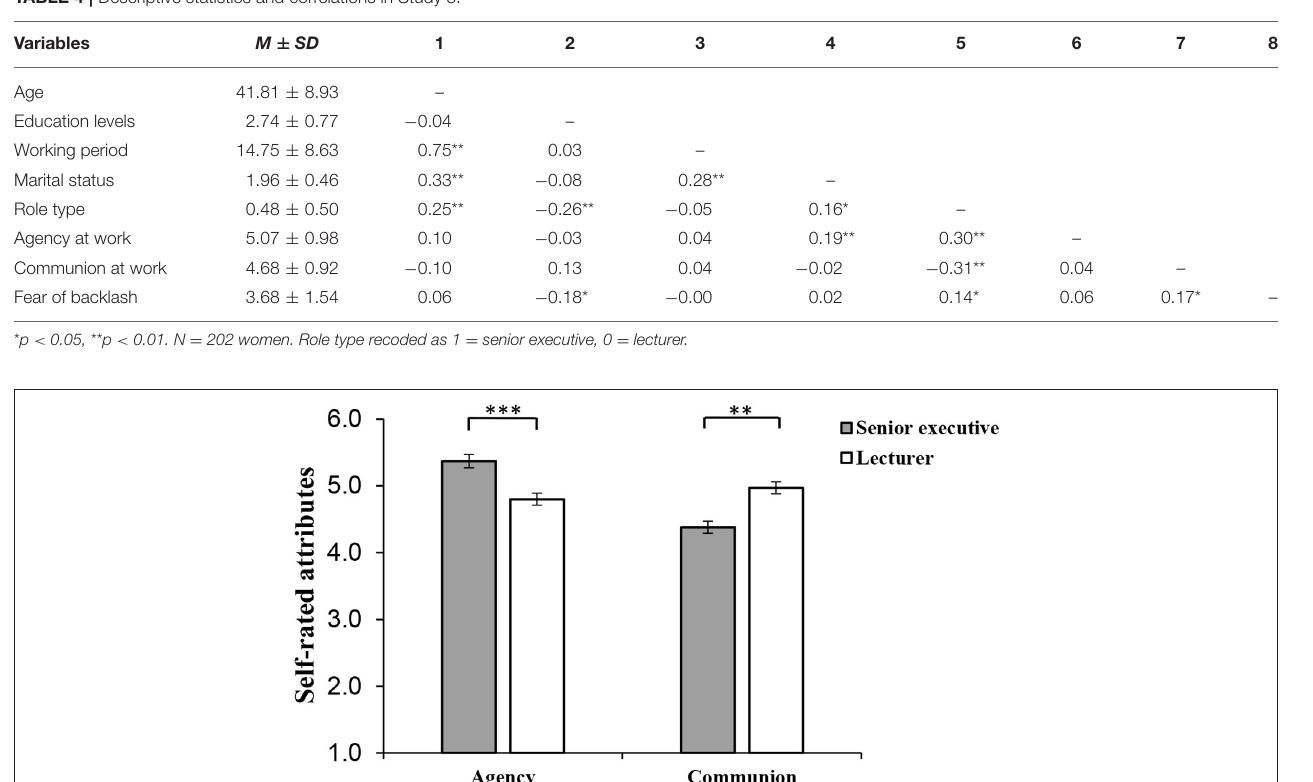
effect of fear of backlash on self-reported agency with the role types of